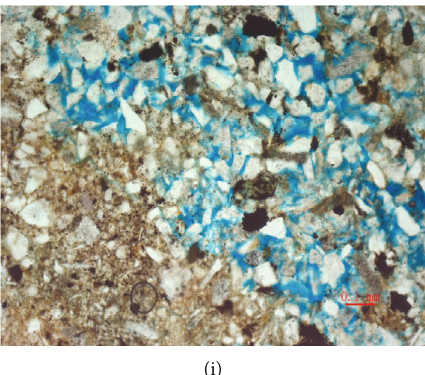
Figure 2: Photos of cores and thin sections of mudstones of di ff erent lithofacies in the Qigequan Formation. (a) S-23: pure mudstone; horizontal bedding develops and sandwiches organic layers. (b) Tn-18: pure mudstone; pores are di ffi cult to observe. (c) Tn-18: pure mudstone; pores are di ffi cult to observe. (d) Tn-18: silty mudstone; horizontal bedding is developed and microfractures are visible. (e) Tn-18: silty mudstone; the grains are mainly quartz and feldspar, and a small number of pores can be seen. (f) Tn-18: silty mudstone; the grains are mainly quartz and feldspar, and a small number of pores can be seen. (g) Tn-18: sandy mudstone; the mudstone diagenesis is weak. (h) Ts-1: sandy mudstone; the sandy particles are distributed in bands, and the particles are mainly quartz and feldspar. (i) Ts-1: sandy mudstone; obvious intergranular pores are developed in the sandy